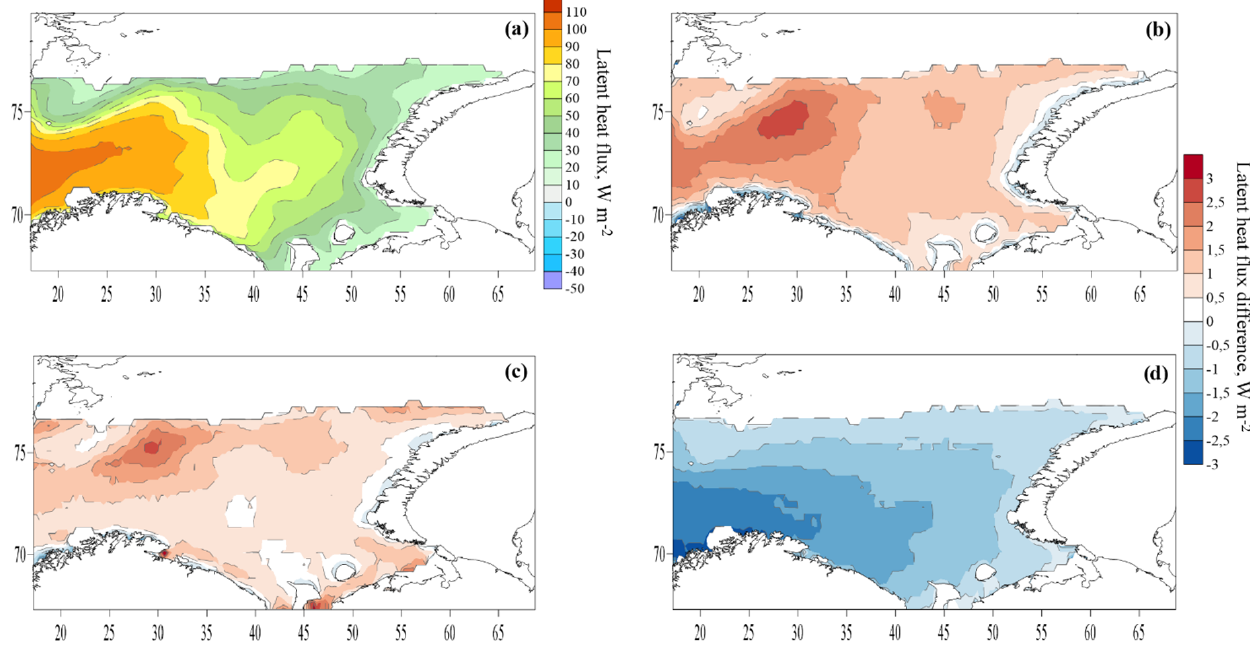
Figure 17. Mean latent heat flux in experiment C55 (a) and the flux difference in experiments T1–C55 (b) , O2–C55 (c) and D3–C55 (d) during cold-air